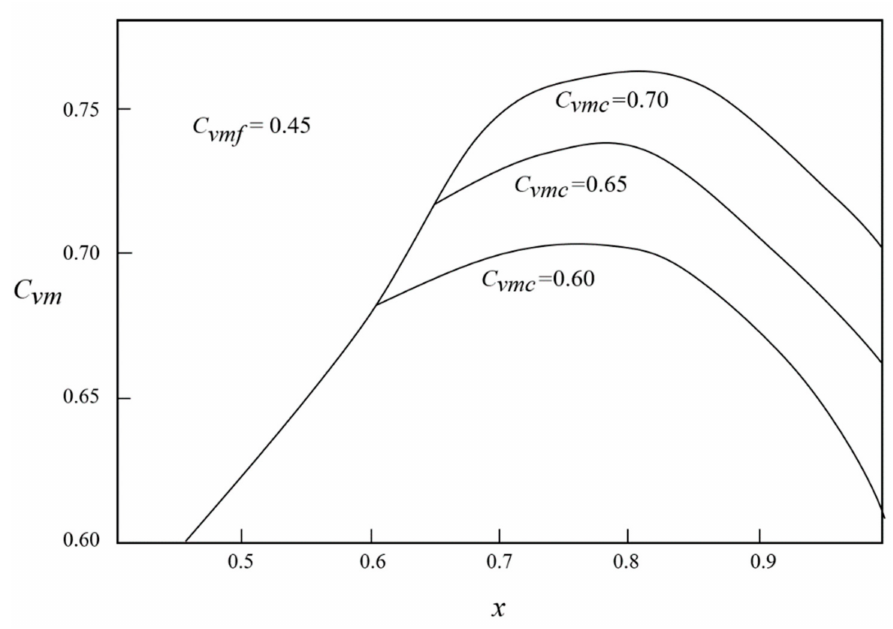
Figure 2. (Source elaborated by authors based on [20]). The relationship between mass ratio of coarse particles and limit